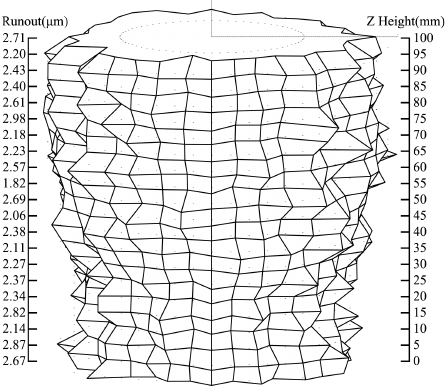
Figure 4. The cylindricity error measurement results of shaft